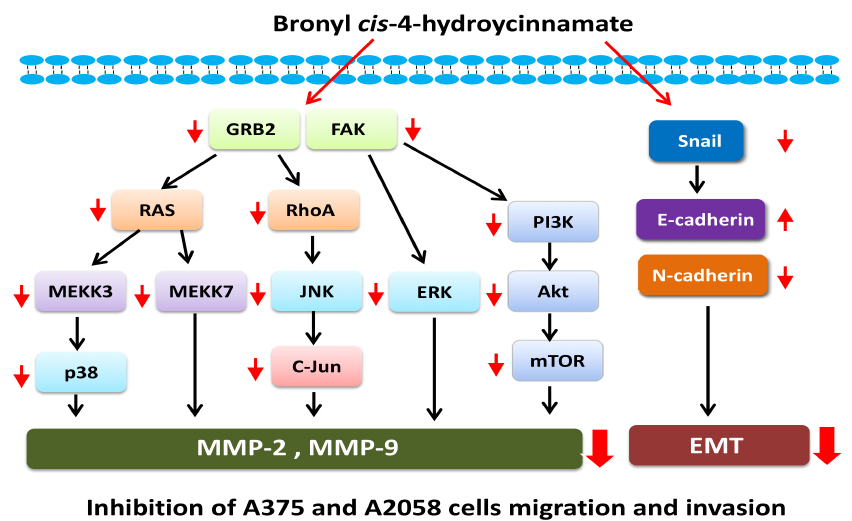
Figure 9. Proposed signaling pathways for bornyl cis -4-hydroxycinnamate-mediated inhibition of A2058 and A375 melanoma cell migration and